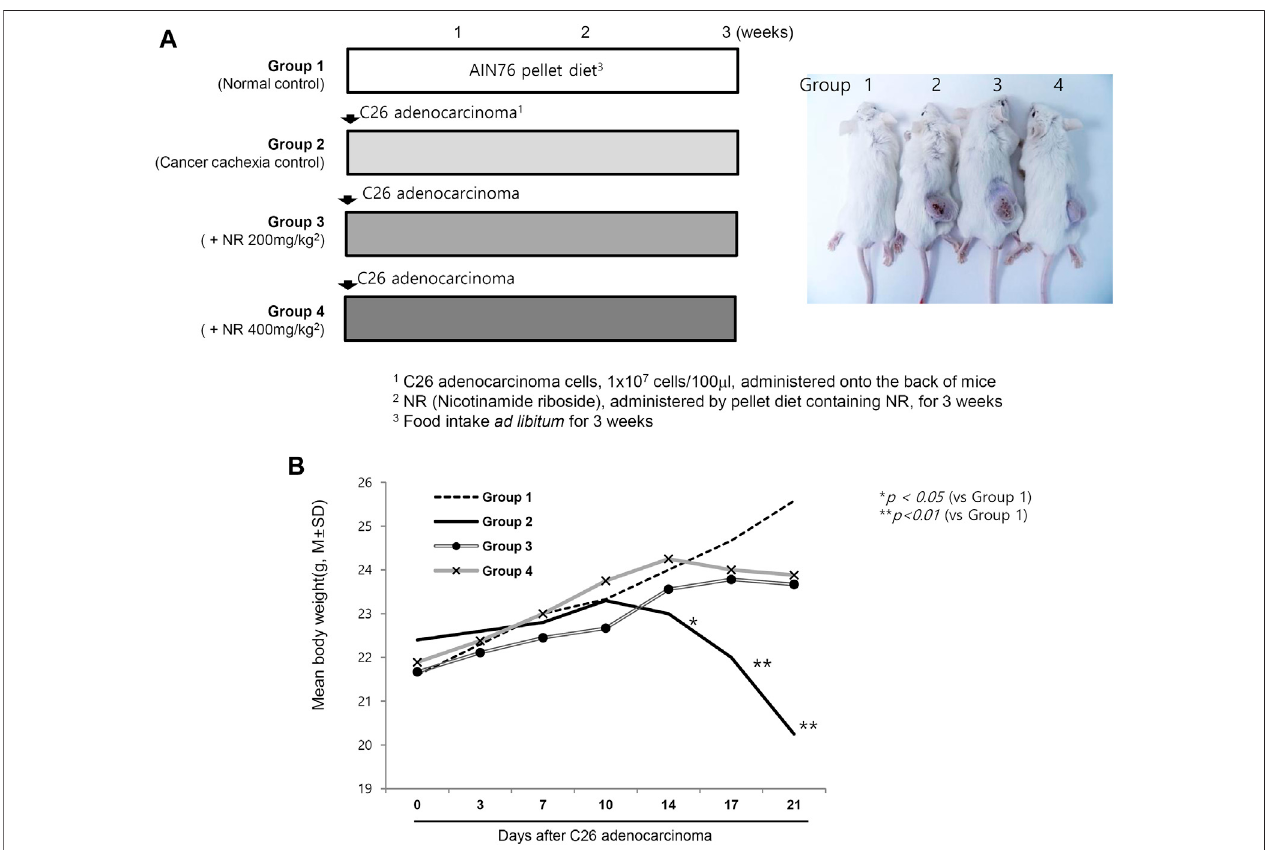
FIGURE1| DietaryintakeofNRaspelletdiettomitigateC26adenocarcinoma – inducedcancercachexia. (A) Schematicprotocolforexperiment Balb/c micewere administered with 1 × 10 7 cells/ml on side of abdomen. Right picture shows representational tumors according to the groups. Tumor growth did not differ according to the groups. (B) Daily measurement of body weight according to the groups. Body weights after 2 weeks were signi fi cantly decreased in Group 2 compared to Group 3 and Group 4. (C) Representationalgrossmorphologyofthighincluding gastrocnemiusmuscle.Signi fi cantatrophy wasnotedinGroup 2( p < 0.01 ).Using imaging analysis, individual muscle mass of leg was measured and averaged according to the groups. The mean size and volume of resected C26 adenocarcinoma xenograft after 3 weeks. (D) Mean tumor volume and tumor masses according to the groups. Though different in body weights and general condition, NR administration did not affecteithertumorvolumeortumormasses.Thoughomitted,themeanamountsofdailyfoodintakewerenotdifferedaccordingtothegroups,suggestingthatchanges in either appetite or food consumption was not differed according to the